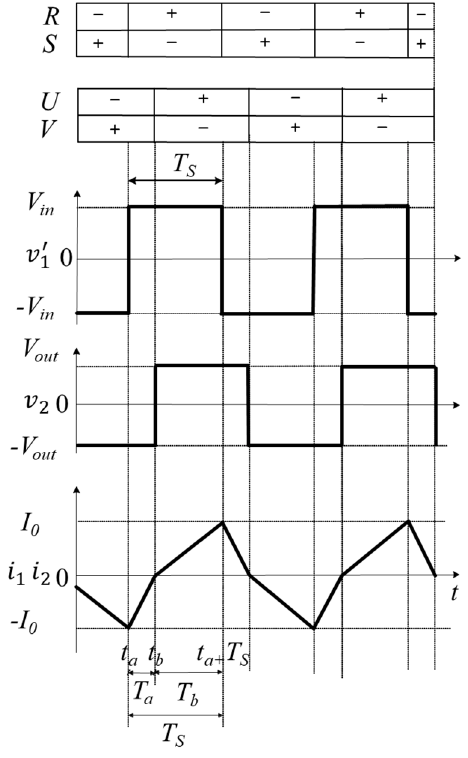
Figure 3. Voltage and current operation waveforms of conventional SAB DC–DC converter.